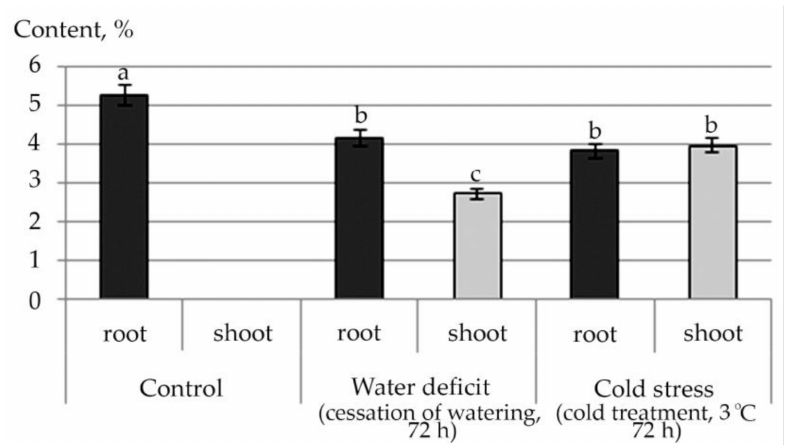
Figure 7. Changes in the content of fatty acid esters in R. semenowii under stress conditions by the example of Ethyl 9,12,15-octadecatrienoate (Ethyl 9 α -linolenate, linolenic acid ethyl ester). Values presented are means ( ± SD). Different letters above the bars represent significant differences at p ≤ 0.05, n = 3 plants in each of 3 replicates for all